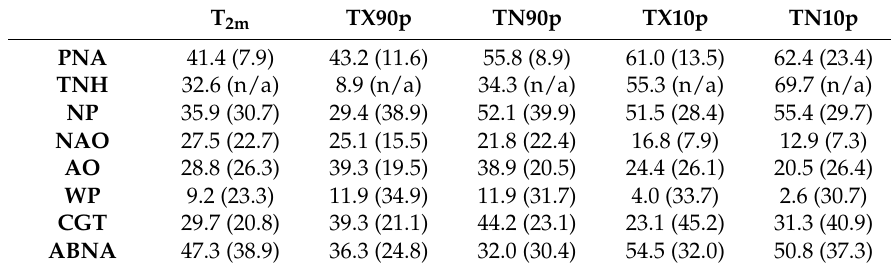
Figure 3. DJF mean T 2m anomalies (contours, interval 0.3 °C), regressed on the pattern indices. The positive and negative anomalies, significantly correlated with the pattern index at the 5% level, are red- and cyan-shaded, respectively. The zero line is in bold. Table 2. Percentages of the North American (20–80° N, 170–50° W) land in which the field anomalies are significantly different from zero at the 5% level for the surface temperature and temperature extreme anomalies, in association with the teleconnection indices. Numbers outside and inside parentheses are the results in DJF and JJA, respectively.